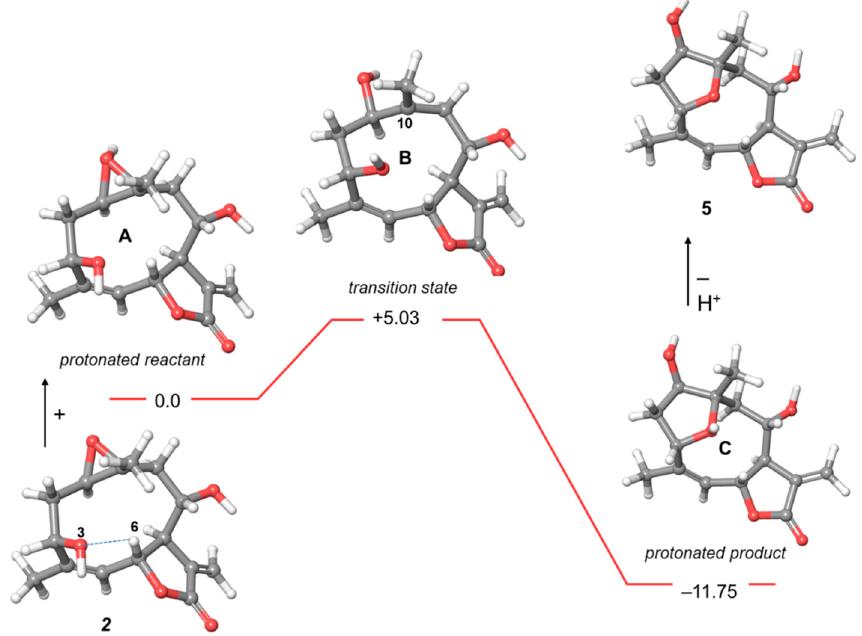
Figure 1. Energy profile of the transformation of 2 into 5 . Relative energies are reported in kcal/mol. The hydrogen bonding interaction O-3 . . . H-6 is represented with a dashed line.